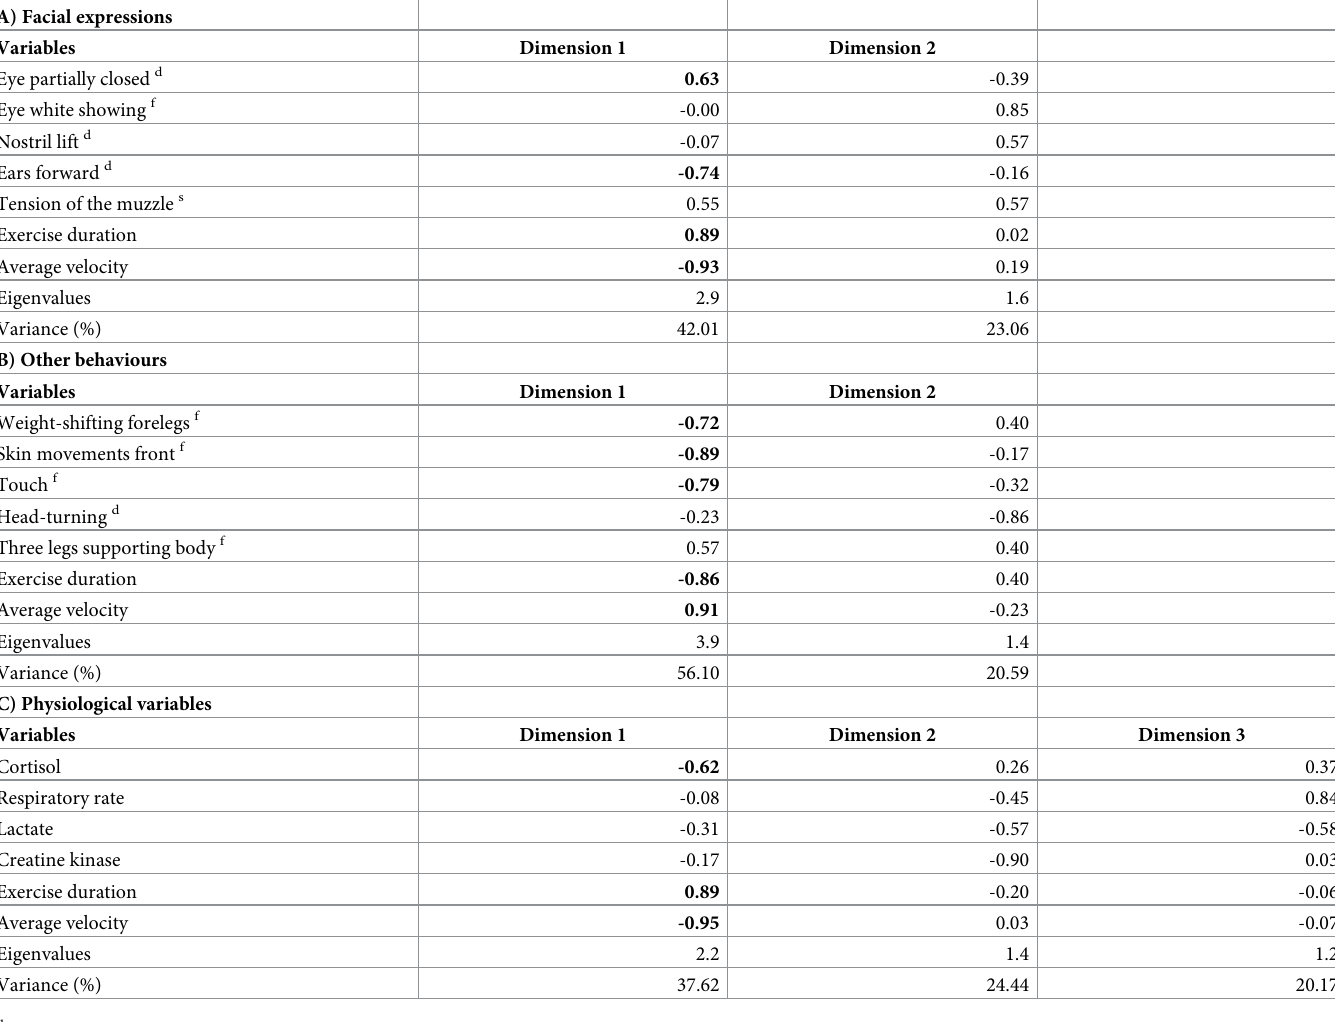
Table 5. Variables’ loadings, eigenvalues and variances of the workload variables and the “differences” of the (A) facial expressions, (B) other behaviours and (C) physiological variables performed by Principal Components Analysis assessed in 14 ranch horses.